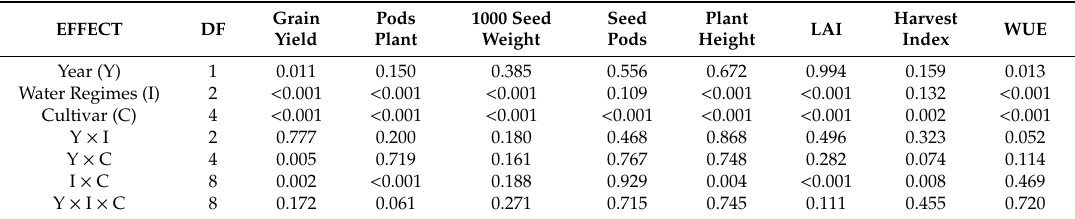
Table 1. Analysis of variance (P) of studied variables as a ff ected by year (Y), water regime (I) and cultivar